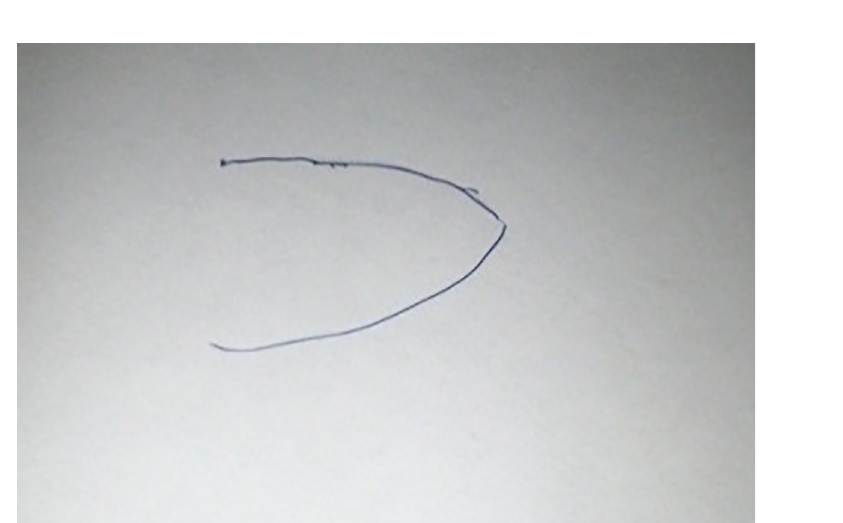
Fig 3. Brian, T2, Tongue cancer. Size and shape